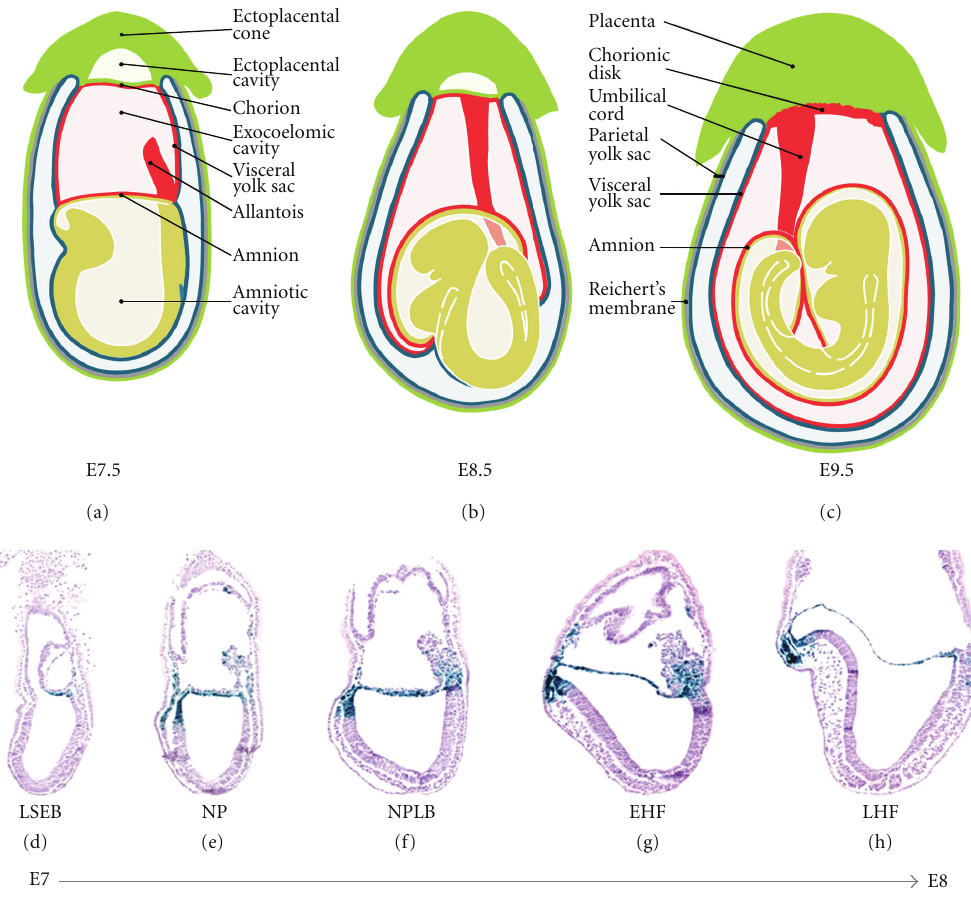
Figure 1: (a)–(c) Schematic representation of a mouse embryo illustrating the position of the extraembryonic tissues before and after axial rotation. During the process of axial rotation the embryo becomes enwrapped in its extraembryonic membranes. Extraembryonic mesoderm is shown in red; yellow represents amniotic ectoderm and embryonic ectoderm (embryonic mesoderm is not depicted); green represents trophectoderm-derived extraembryonic lineages; blue shows extraembryonic endoderm. For more detailed description of the extraembryonic membranes, see [2]. (d)–(h) Sagittal sections through BRE : LacZ mouse embryos in the time range between amnion closure (E7.0) and head fold stages (E8.0). X-gal staining (blue) for β -galactosidase detection in BRE:LacZ heterozygous embryos [5] reports dynamic SMAD1/5/8 mediated BMP signaling in the developing amnion. Abbreviations: E: embryonic day; LSEB: late streak-early bud; NP: neural plate; NPLB: neural plate-late bud; EHF: early head fold; LHF: late head